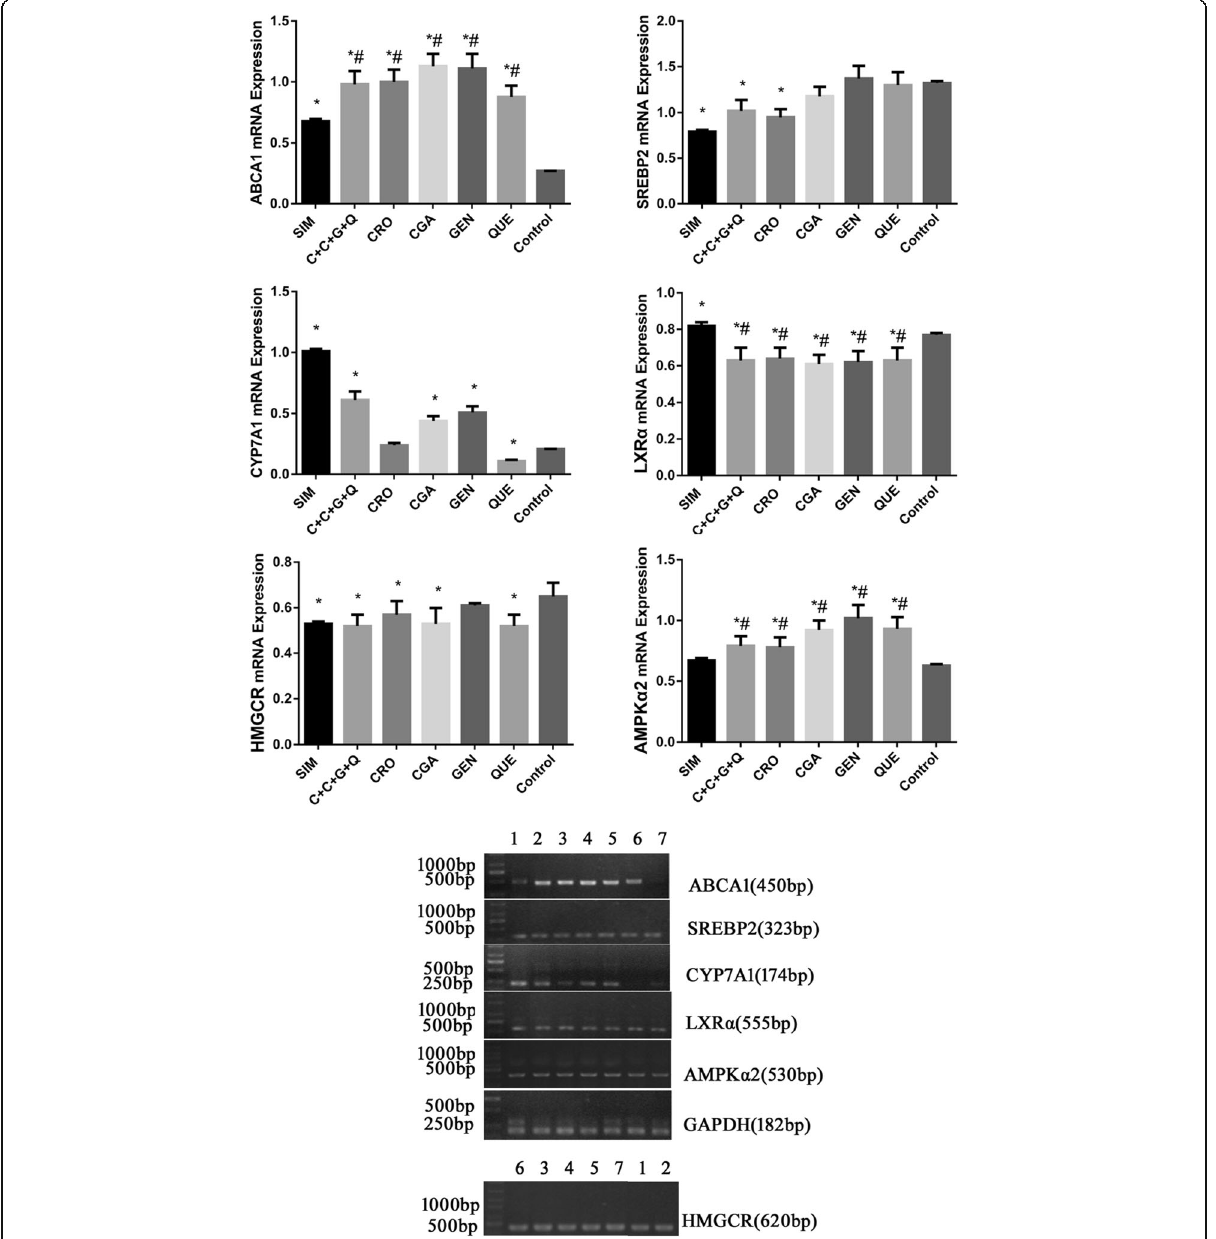
Fig. 4 mRNA expression levels of the regulation cholesterol activities associated genes ABCA1, SREBP2, CYP7A1, LXR α , AMPK α 2 and HMGCR in HepG2 cells. All genes were normalized with GAPDH. HepG2 cells were treated with (1) SIM (10 μ mol/L), (2) C + C + G + Q (1 μ mol/L + 30 μ mol/L + 10 μ mol/L + 10 μ mol/L) (3) CRO (1 μ mol/L), (4) CGA (30 μ mol/L), (5) GEN (10 μ mol/L), (6) QUE (10 μ mol/L) and no drug for (7) Control respectively for 48 h. Data represent as mean ± SEM of three independent experiments. * P < 0.05 vs. control, # P < 0.05 vs.